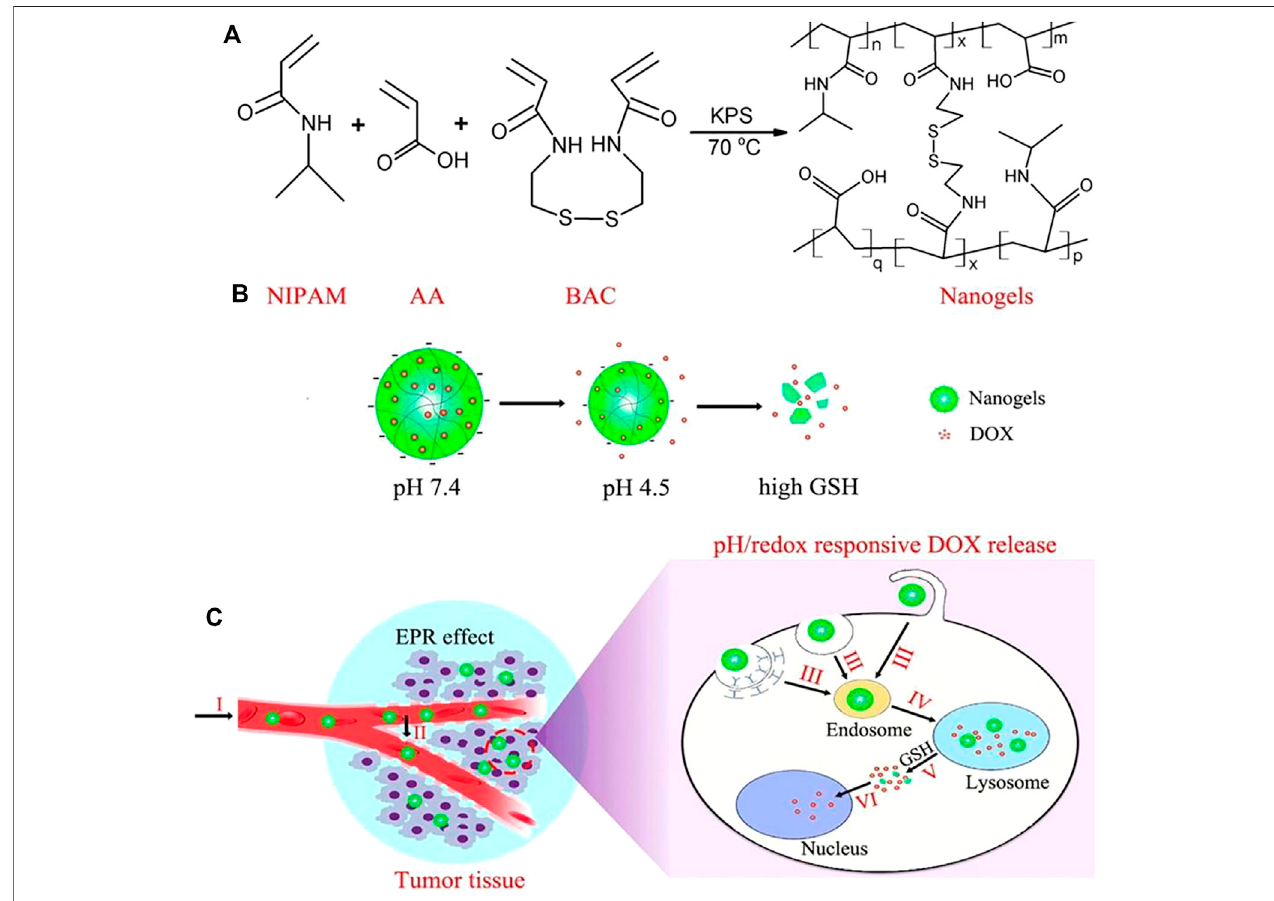
FIGURE9| SchematicillustrationofP(NIPAM- ss -AA)nanogelsforanticancerdrugdelivery. (A) ConstructionofP(NIPAM- ss -AA)nanogels; (B) Characterizationof P(NIPAM-ss-AA) nanogels in response to intracellular microenvironment; (C) Site-directed DOX release delivered (Yang et al., 2016). Copyright (2016) American Chemical